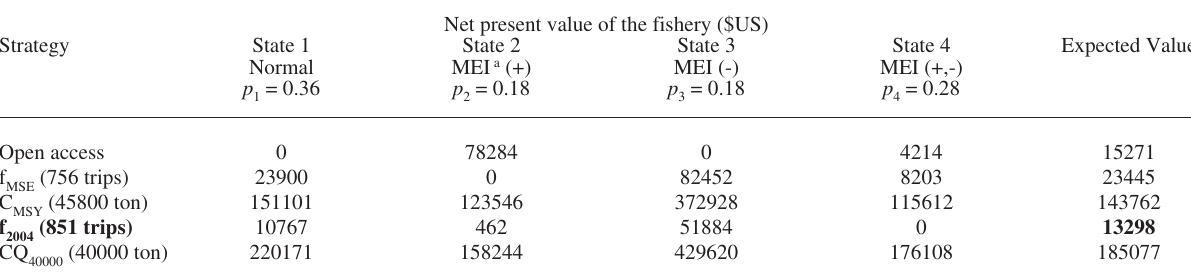
Table 3. – results of the decision analysis with use of Bayesian criterion.